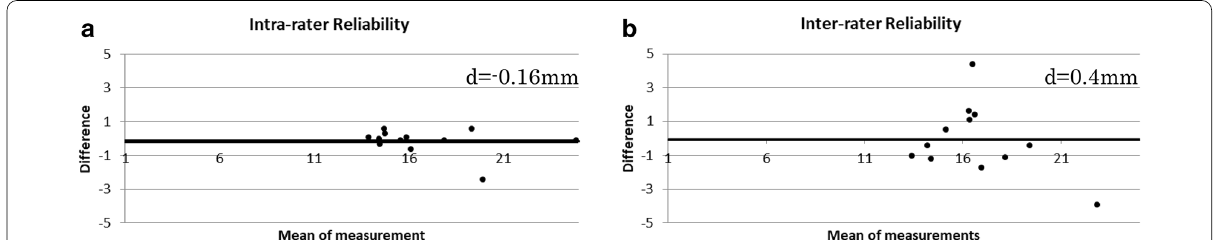
Fig. 3 Bland–Altman plots of intra- and inter-rater reliabilities of ultrasonography to measure skeletal muscle thickness. The values from two independent raters were used to decipher the intra- and inter-rater reliabilities. Bland–Altman plots of the mean measurement against the difference between the measurements are depicted for intra-rater reliability ( a ) and inter-rater reliability ( b